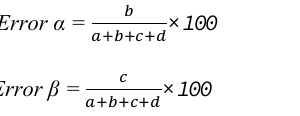
Table 1. Obtained values for used parameters in each iteration of the algorithm